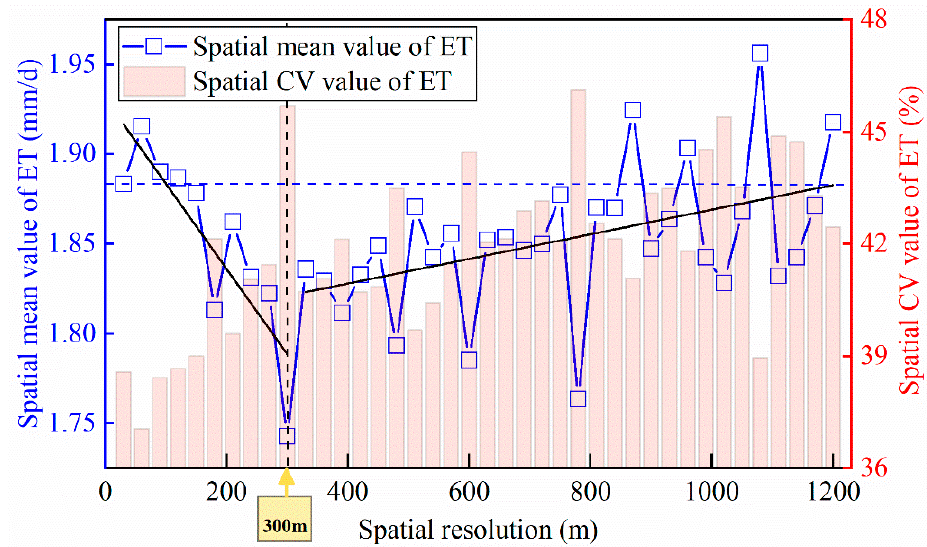
Figure 9. Spatial mean values and coefficients of variation of the simulated ET at different spatial resolutions (the blue dotted line represents the value of the estimated ET at spatial resolution at 30 m, the black dotted represent the critical point at the spatial resolution of 300 m).